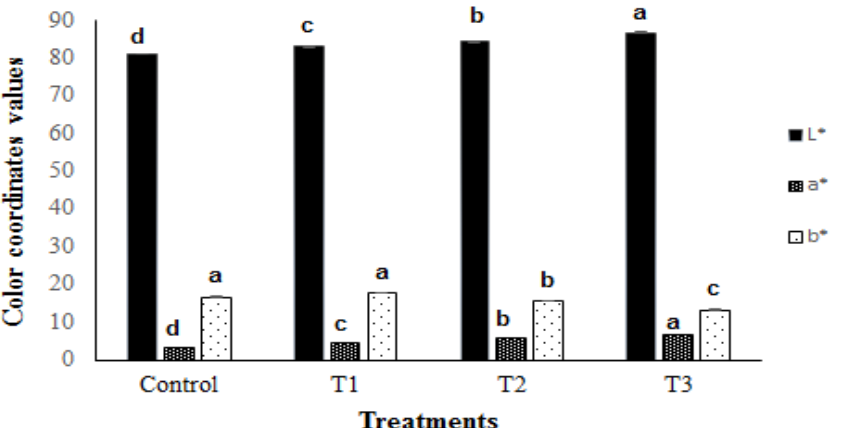
Figure 1. Color coordinates of ice cream samples made from camel milk formulated with BRB. Control: ice cream made without BRP. T1: ice cream made by replacing 25% of skim milk powder with BRP. T2: 50% replacements of skim milk powder with BRP. T3: 75% replacements of skim milk powder with BRP. Measurements were recorded as L* to express (lightness), +a* (redness) and +b* (yellowness) based on CIE (Commission Internationale de I’Eclairage) color coordinates. Values represent the mean ± SE; n = 3. Means with different small (a – d) superscripts are significantly different between the treatments ( p ≤ 0.05).